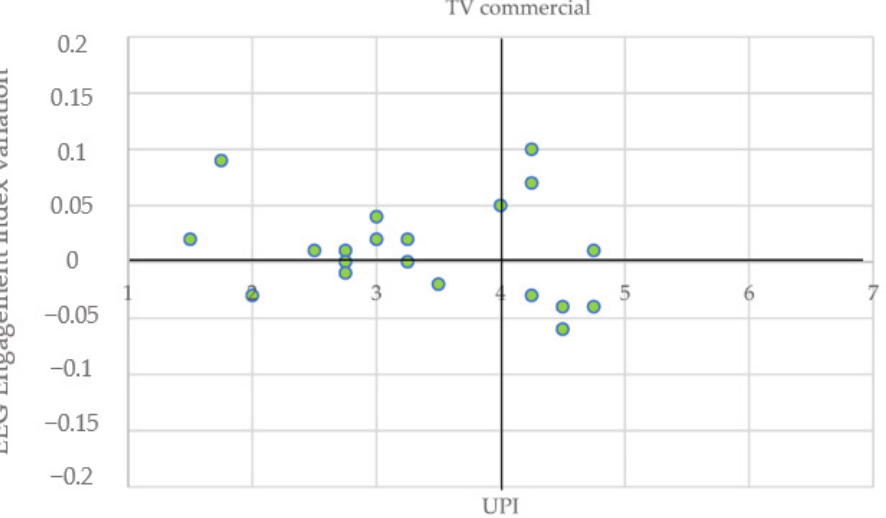
Figure 10. TV commercial—Quadrant model of EEG engagement index variation vs. UPI.